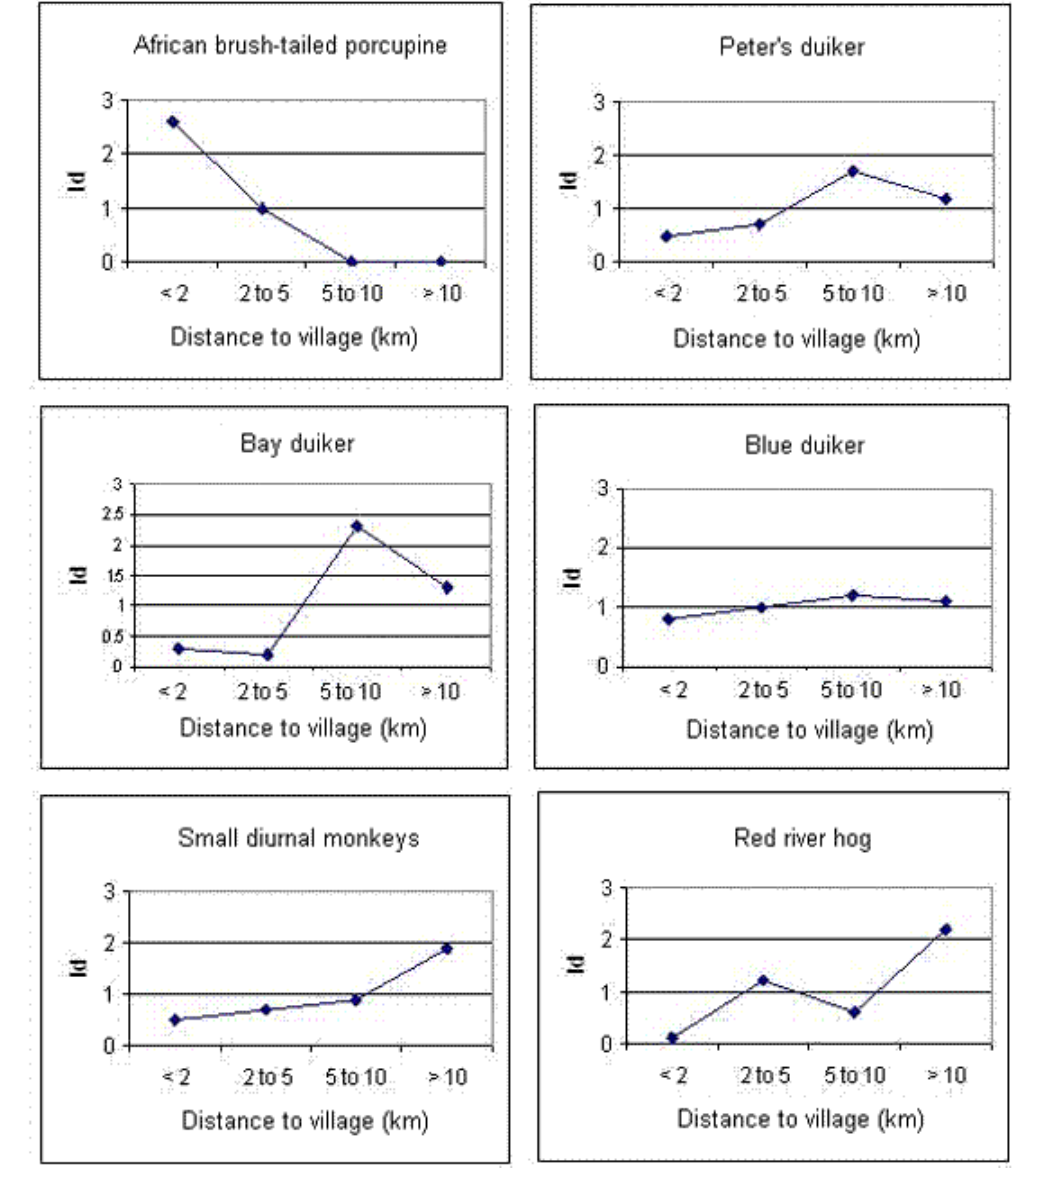
Fig. 6. Index of kills (Id) at various classes of distance from a village for six